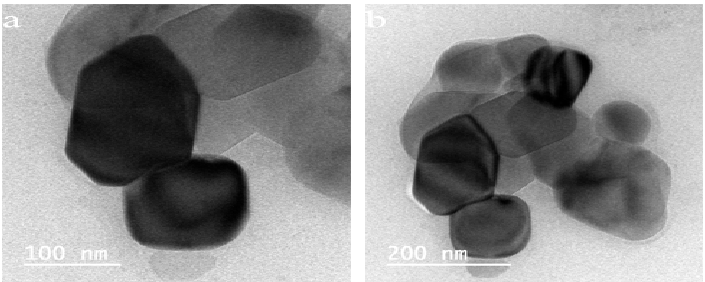
Figure 6. HR-TEM images of Sr (0.1)-doped ZnSe nanoparticles at 100 nm ( a ) and 200 nm ( b ).